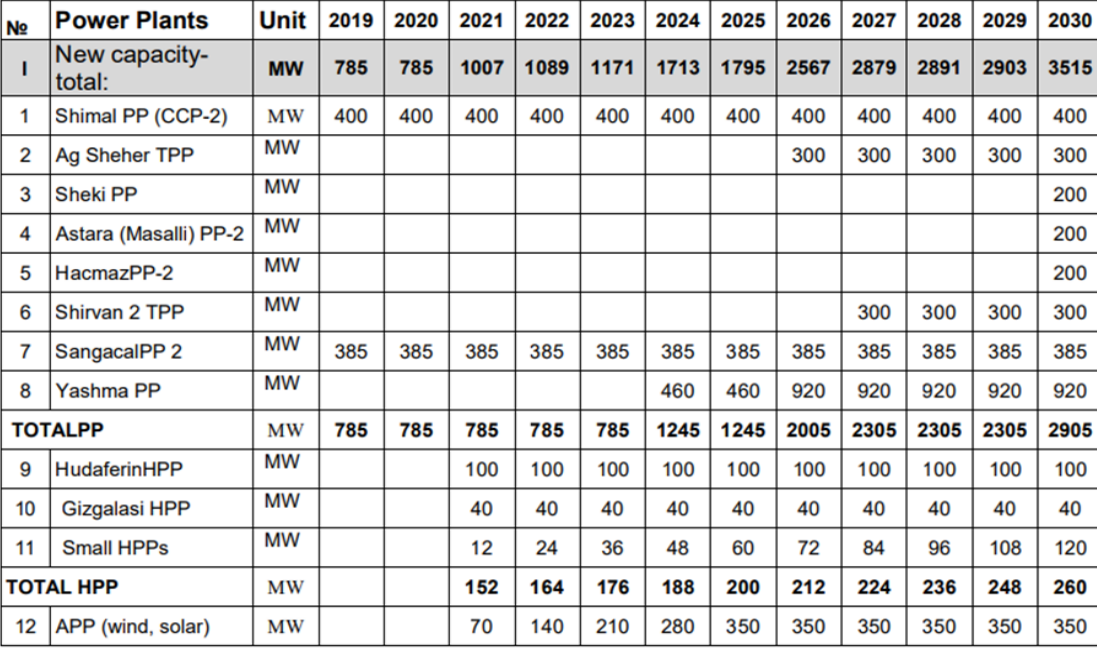
Source: State Statistical Committee of the Republic of